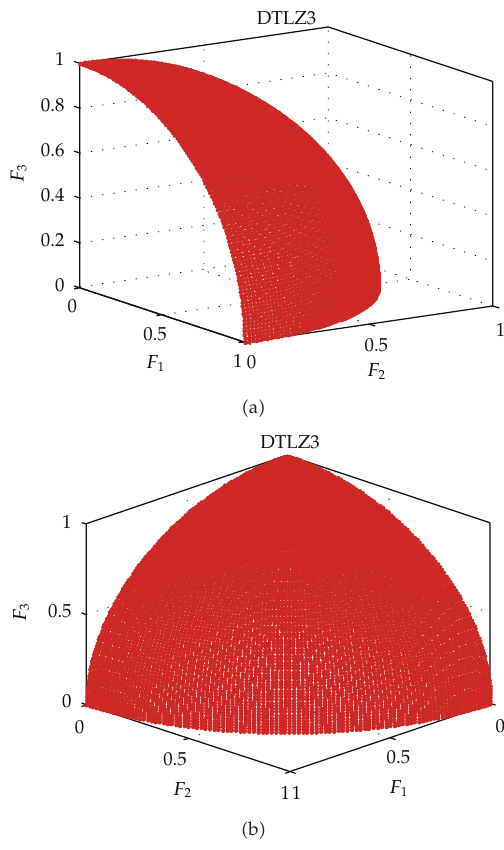
Figure 17: The true Pareto optimal front on